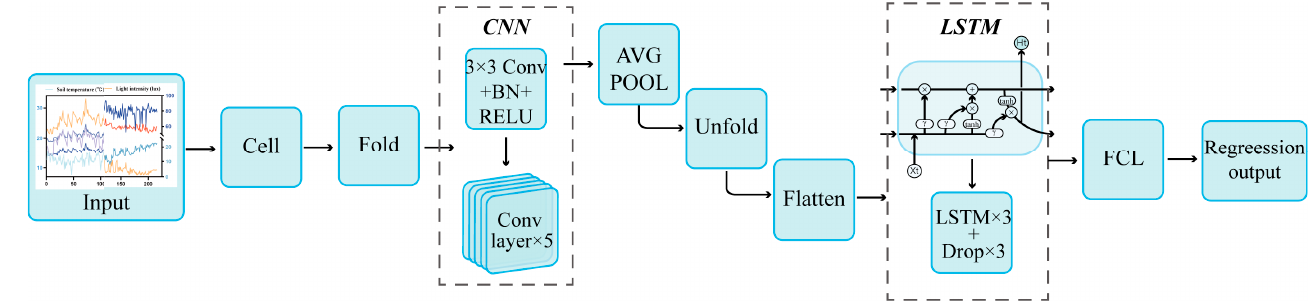
Figure 2. The network structure of CNN-LSTM. Colored lines are environment parameters.